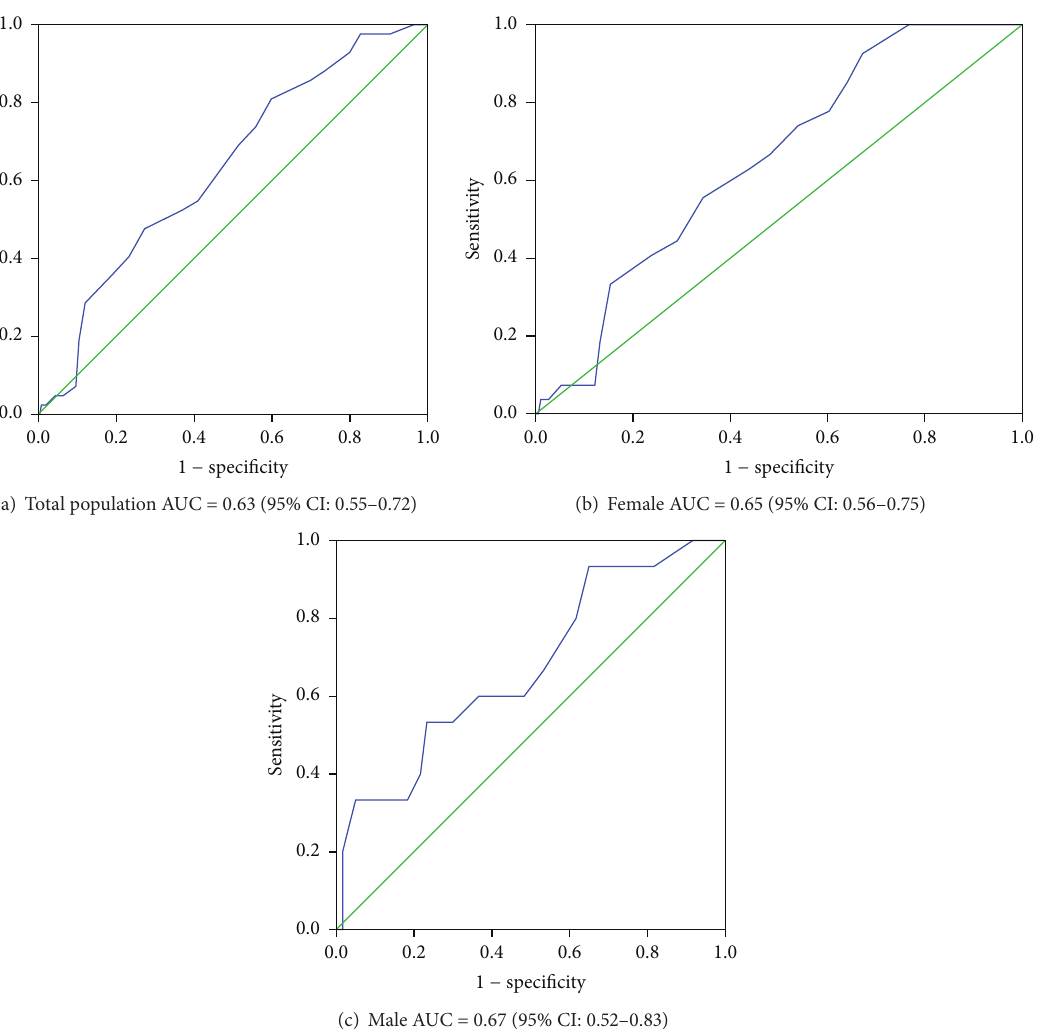
Figure 3: The receiver operating characteristic (ROC) curves for detecting undiagnosed T2D using FINDRISC and HbA1c (%) among outpatients in Botswana: (a) total population, (b) females, and (c) males. (a–c) Diagonal segments are produced by